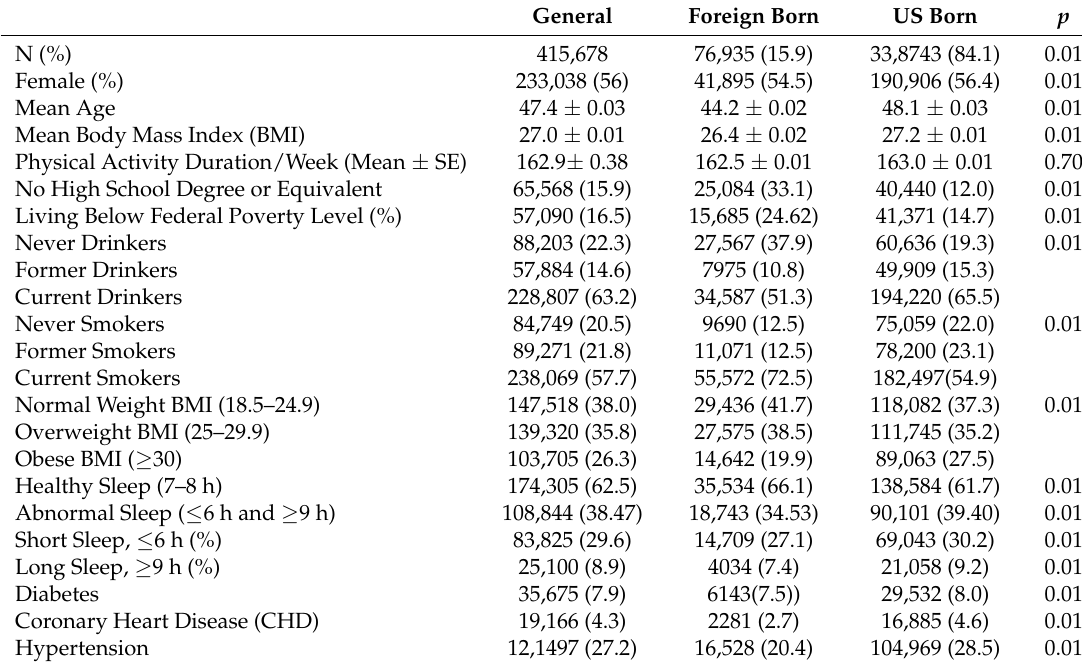
Table 1. Demography by foreign-born